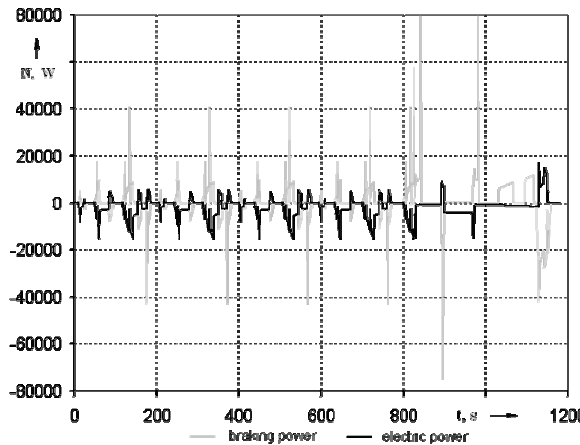
Fig 19. Power characteristics of parallel hybrid drive, New European driving cycle